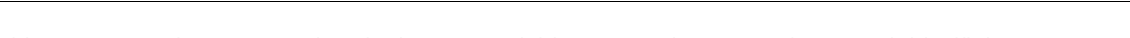
Table 5. Community Supported Agriculture (Canalside CSA) and Supermarket Net Yield Efficiency (NYE)